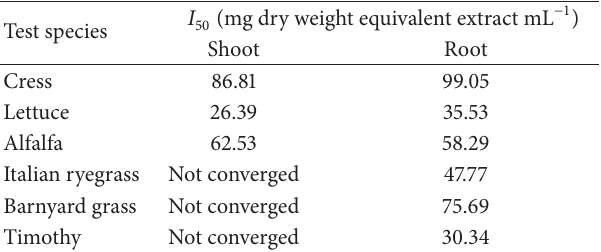
Table 3: 𝐼 50 values of O. tenuiflorum plant extract for the shoot and root growth of different plant